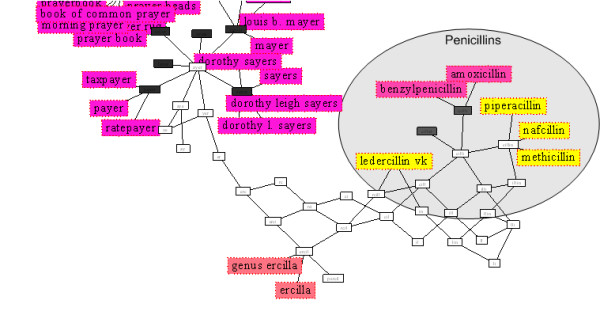
Example of similarity based retrieval and knowledge induction. Ayercillin, a relatively new drug unknown to the system, is likely to be a penicillin because of its high contextual similarities with known penicillines.